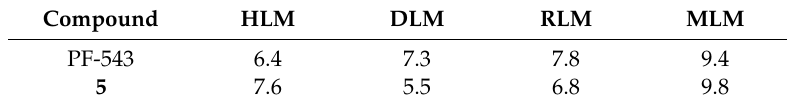
Table 1. In Vitro profile of PF-543 and compound 5 determined using human (HLM), dog (DLM), rat (RLM) and mouse (MLM) liver microsomal stability (% remaining during 30